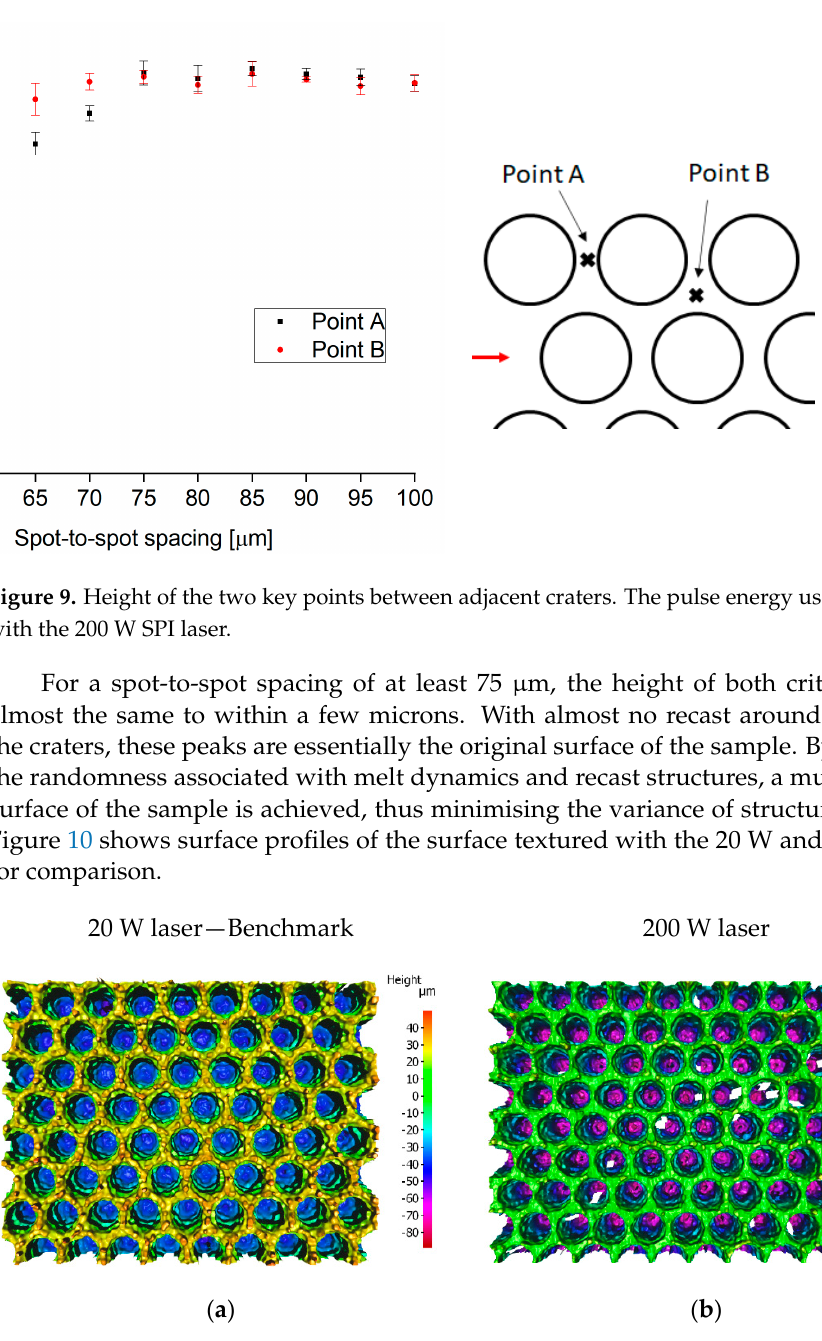
Figure 8. Cross-section surface profile of topographies achieved by the 20 W laser ( a ) and 200 W laser ( b ).